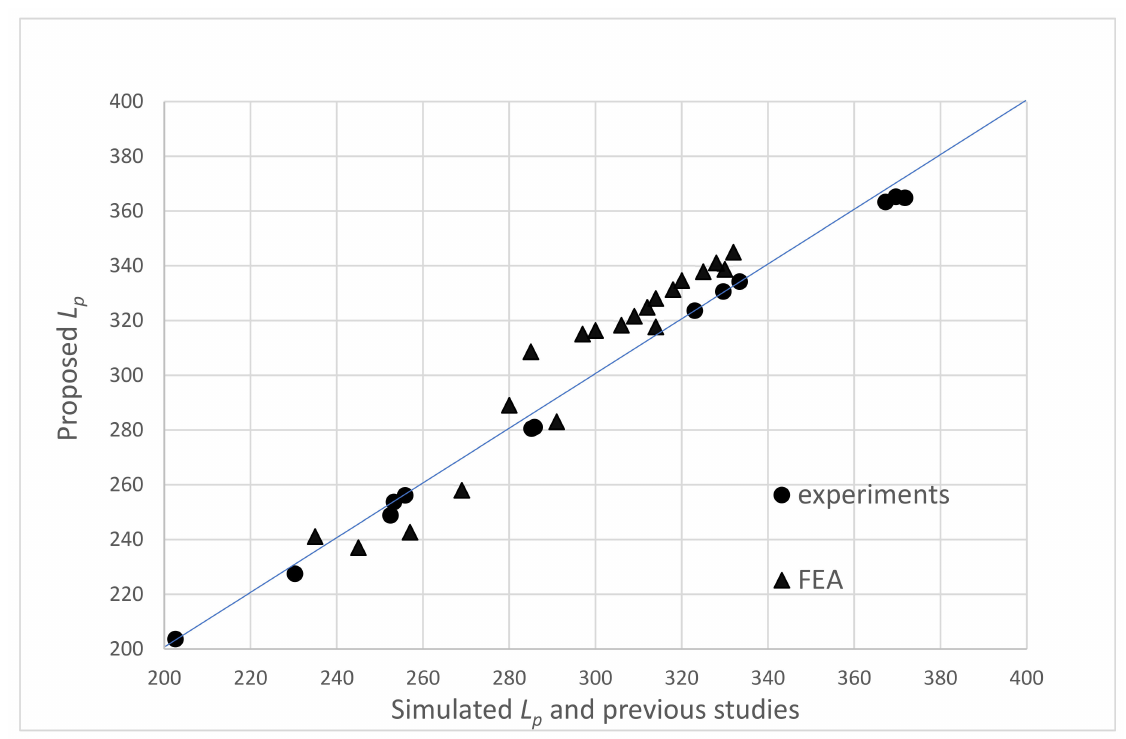
Figure 10. Comparison of FEA and experimental dataset and the proposed L p